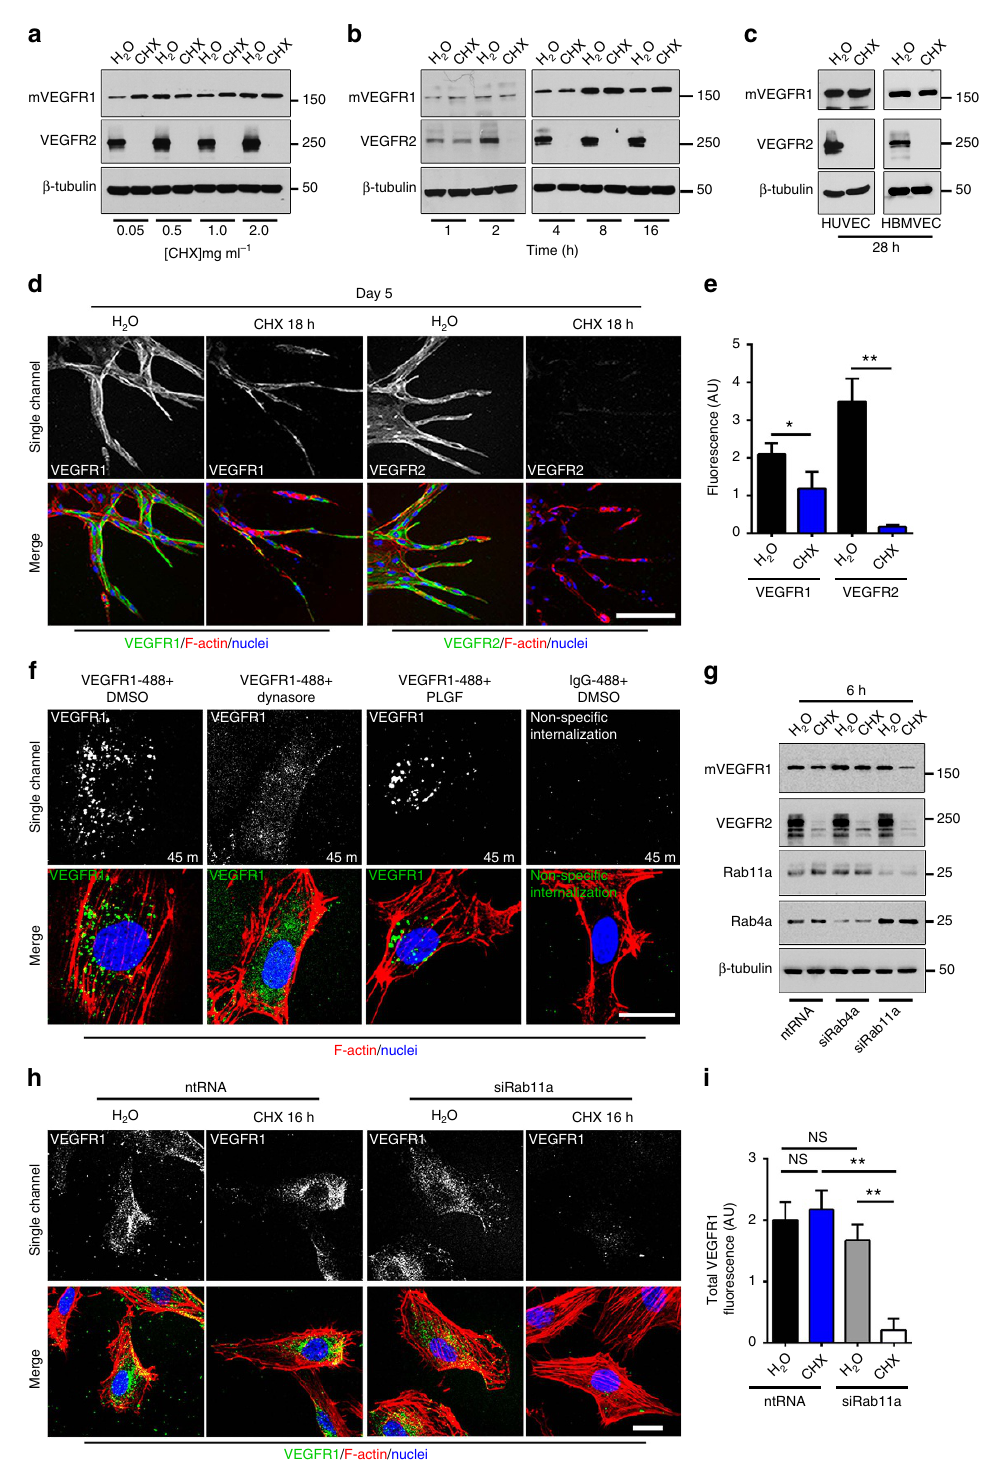
Figure 1 | mVEGFR1 is stable and constitutively internalizes in endothelial cells. ( a ) Immunoblot of HUVEC treated as indicated for 8h; CHX, cycloheximide; three replicates. ( b ) Immunoblot of HUVEC treated as indicated; three replicates. ( c ) Immunoblot of HUVEC or HBMVEC with indicated treatments; two replicates. ( d , e ) ( d ) Immunofluorescence for VEGFR1 or VEGFR2 in HUVEC angiogenic sprouts with indicated treatments, scale bar: 100 m m. ( e ) Quantification of fluorescence via integrated density. (VEGFR1 n ¼ 18 sprouts per condition; VEGFR2, n ¼ 25 sprouts per condition); three replicates. ( f ) VEGFR1 immunofluorescence of HUVEC with indicated treatments; three replicates, scale bar: 20 m m. ( g ) Immunoblot of HUVEC at 48h post-knockdown (KD) with indicated treatments; two replicates. ( h , i ) ( h ) VEGFR1 immunofluorescence of HUVEC 24h post KD with indicated treatments, scale bar: 20 m m. ( i ) Quantification of fluorescence via integrated density. (No. of cells: ntRNA/H 2 O, n ¼ 22; ntRNA/CHX, n ¼ 23; siRab11a/H 2 O, n ¼ 19; siRab11a/CHX, n ¼ 14); three replicates. Statistics: Shown are means þ 95% CI. One-way ANOVA with pairwise comparison and post-hoc Tukey’s range test. * P r 0.05; ** P r 0.01; NS, not significant.